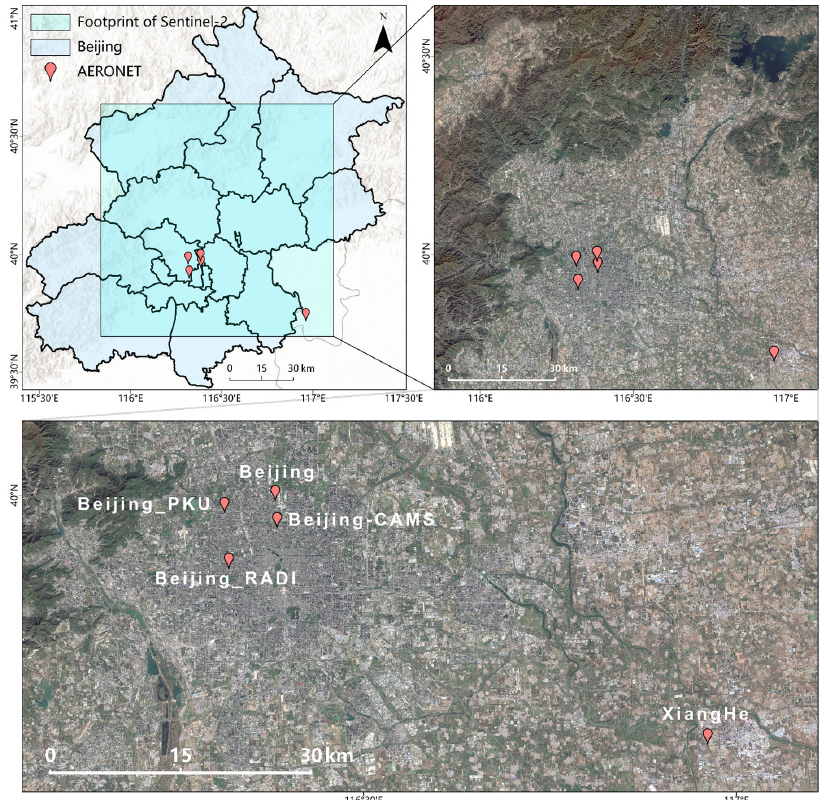
Figure 1. Footprint of Sentinel-2 (study area) in Beijing (top left) and the distribution of ground-based AERONET sites (top right).